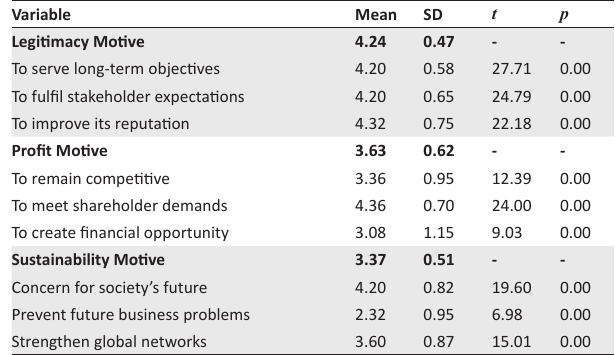
TABLE 2: Summary statistic for banks’ motives for corporate social responsibility practices.